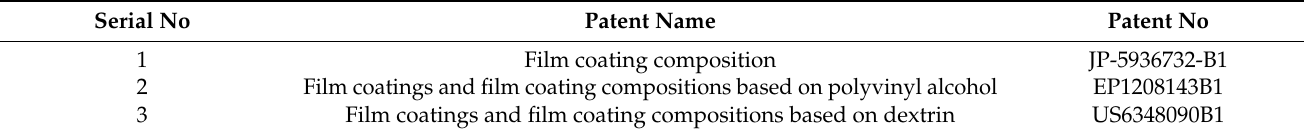
Table 1. Representing some patents regarding